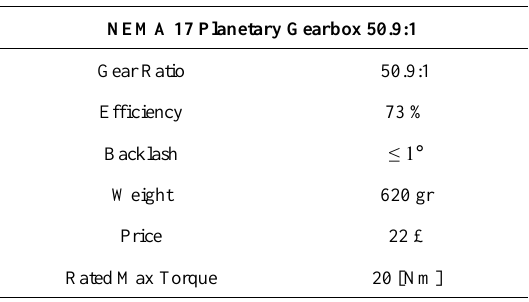
Table 2. Performance parameters of the planetary